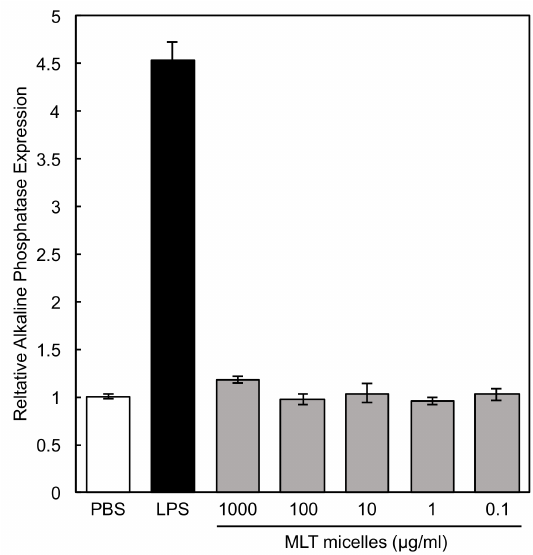
Figure 10. Dose dependent NF- κ B expression levels measured by secreted alkaline phosphatase of RAW 264.7 macrophages in the presence of MLT micelles. LPS (1 µ g / mL) was used as positive control. Data shown as the mean ± S.D. ( n =